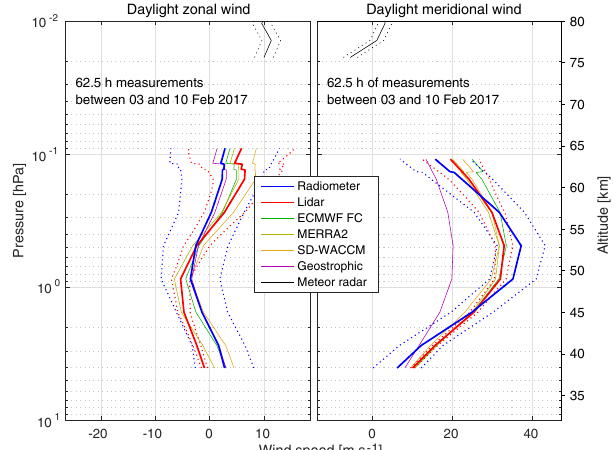
Figure 4. Mean daytime zonal and meridional wind profiles for the observation period 3–11 February 2017 measured by the wind ra- diometer WIRA and the RMR lidar in comparison with models, re- analyses and geostrophic wind calculations from MLS geopotential heights. All middle-atmospheric comparison data have been con- volved with WIRA’s averaging kernels according to Eq. (2) and cut at the limits of the trustworthy altitude range of the coincident ra- diometer observation. The discontinuities in the profiles visible at the uppermost altitudes originate from the averaging over obser- vations with slightly different altitude coverage. At the uppermost altitudes the simultaneous observations from the meteor radar (not convolved) are shown. The random errors of all measurement data are denoted by dotted lines. Only data from times when lidar and ra- diometer were both operated in their respective daylight mode have been considered in this plot.